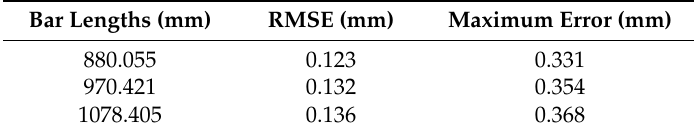
Table 7. Bar length measurement errors under different scale bar lengths.